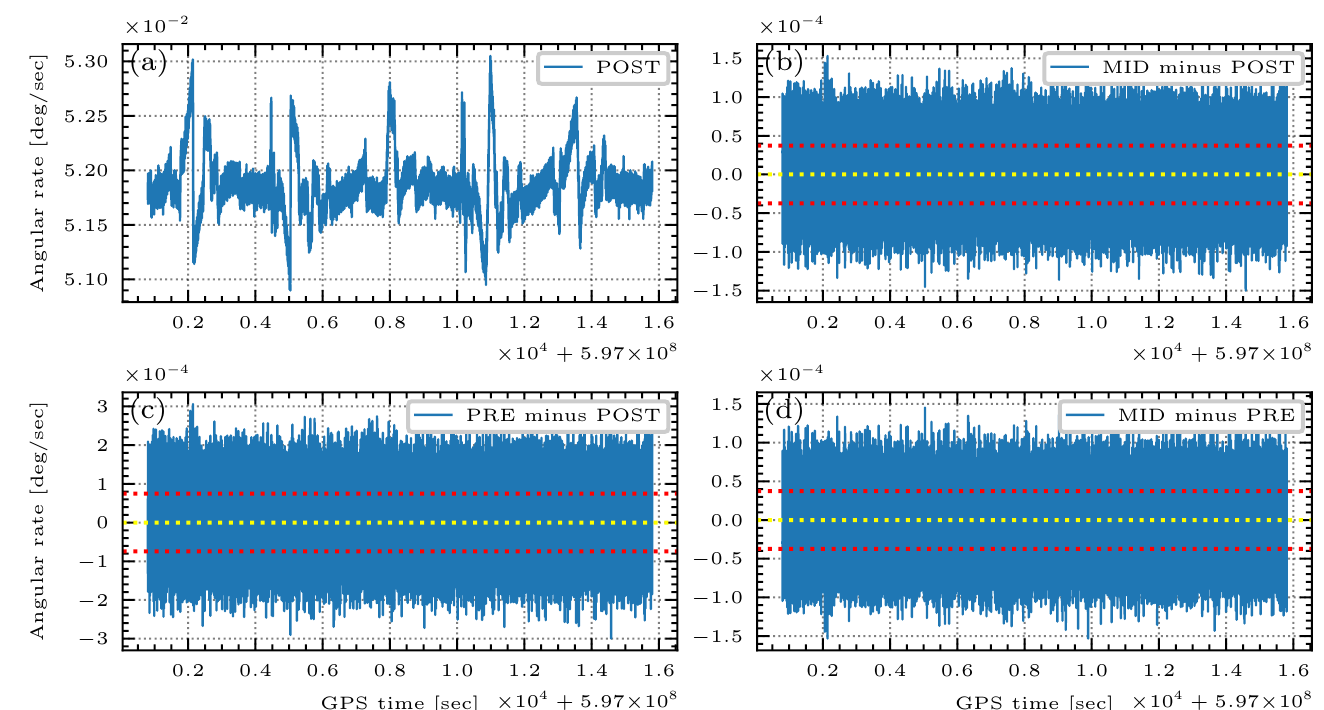
Figure 2. An example (5 December 2018 Sat-C IMU-3) of angular rate computation. ( a ) is the angular rate result computed with POST method. ( b – d ) denote the angular rate differences between three methods: MID, POST and PRE. In ( b – d ), the mean is marked in dashed yellow line and the 1-sigma variance is marked in red dashed line to quantify the